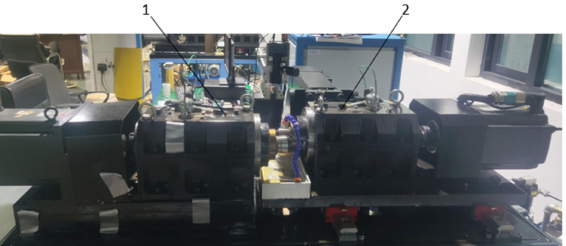
Figure 7. Schematic diagram of the shaft box of the RCF-A test machine. 1. Accompanying axle box; 2. Spindle